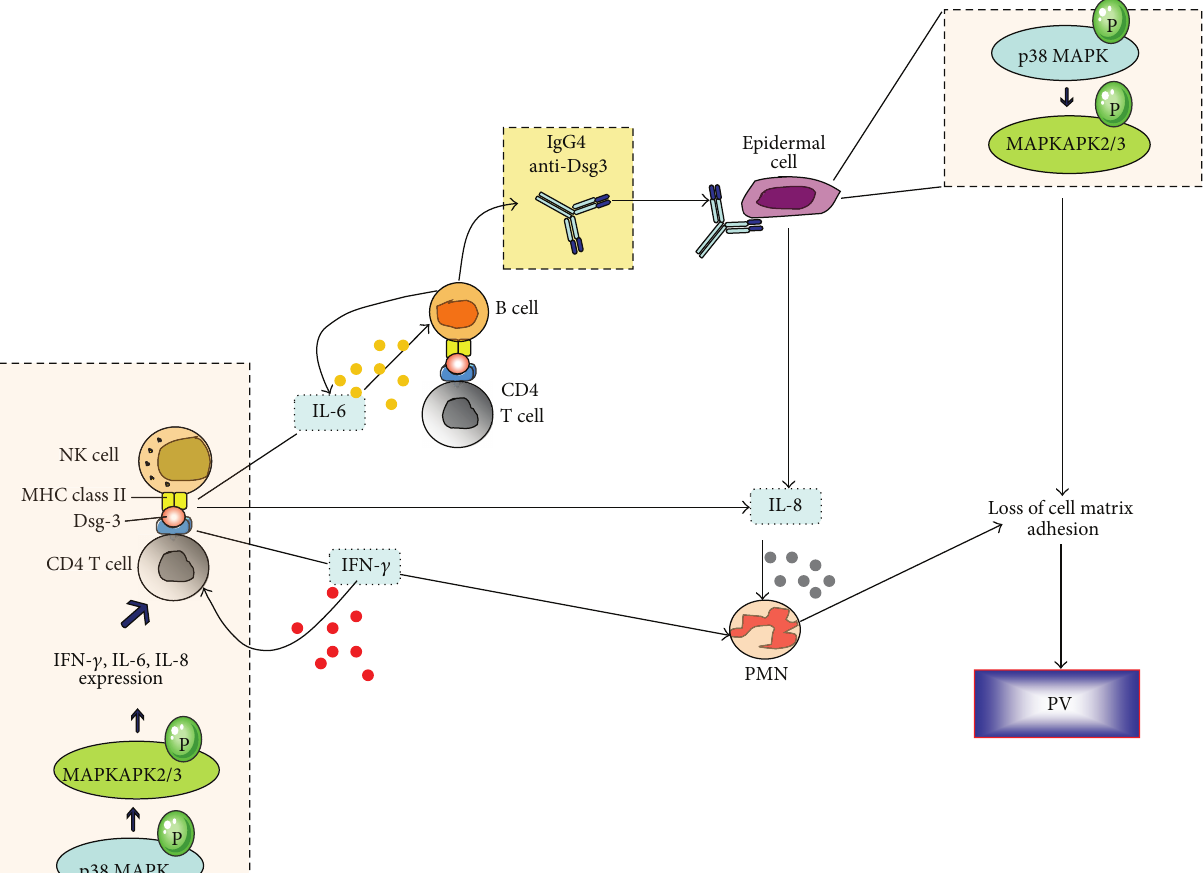
Figure 2: Schematic representation of the suggested interplay between natural killer (NK), CD4+ T, B cells, and polymorphonuclear cells (PMN) during pemphigus pathogenesis [22]. NK cells accumulate from the bloodstream to the epidermis and act as antigen-presenting cells by introducing desmoglein (Dsg3) peptides to CD4+ T cells. p38 MAPK phosphorylation within lymphoid subpopulations such as NK and CD4+ T cells induces expression of IFN- 𝛾 , IL-6, and IL-8 that amplify the inflammatory response, MHC-II presentation, and autoantibody production by B cells. The activated T cells further enhance B-cell anti-Dsg3 secretion and presentation to epidermal cells. Anti-Dsg3 activates the p38 MAPK pathway within keratinocytes leading to MAPK-activated protein kinase 2 (MK-2) mediated heat shock protein 27 (Hsp27) phosphorylation, actin microfilament reorganization, and